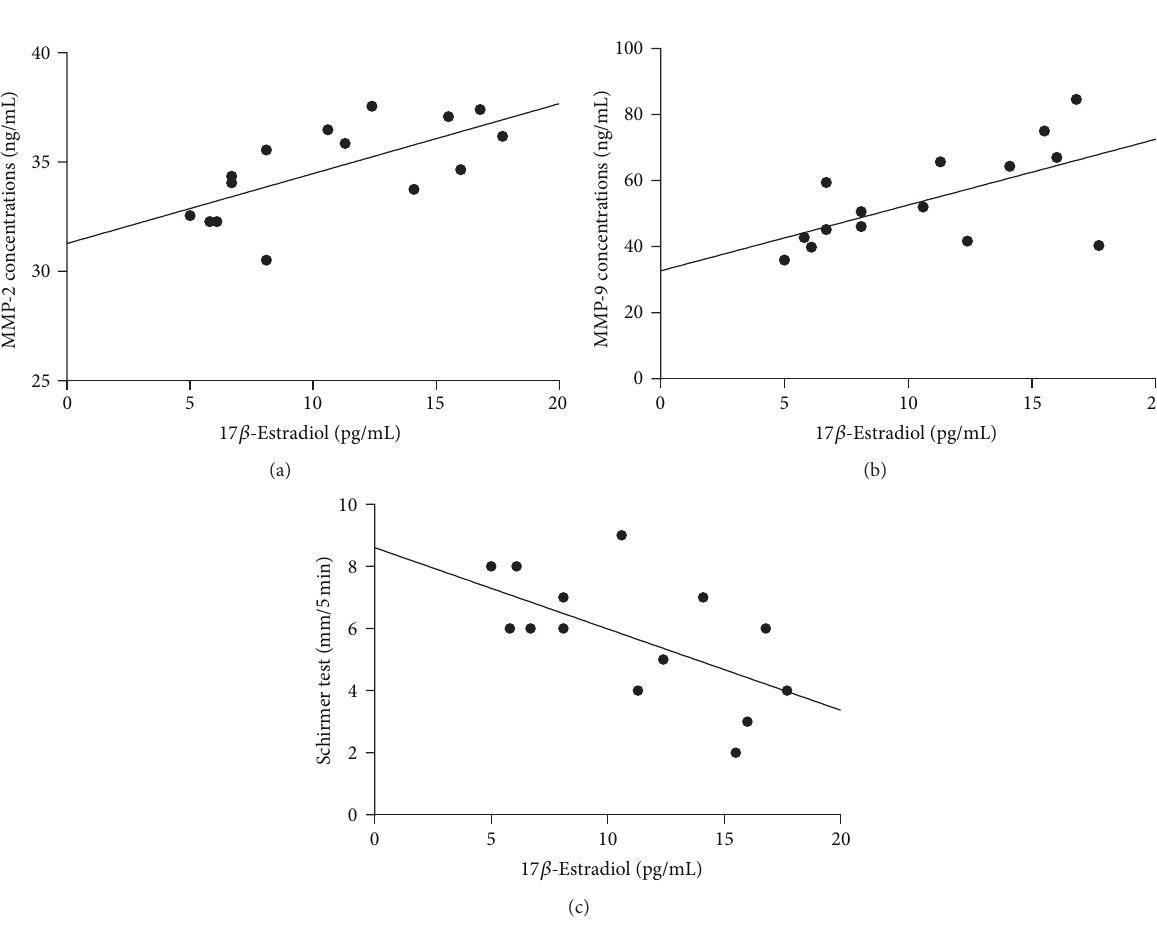
Figure 3: Correlation of 17 𝛽 -estradiol levels with (a) tear MMP-2 concentrations ( 𝜌 = 0.67, 𝑃 = 0.006 ); (b) tear MMP-9 concentrations ( 𝜌 = 0.58, 𝑃 = 0.03 ); and (c) Schirmer test results ( 𝜌 = − 0.58, 𝑃 = 0.02 ). Spearman’s rank correlation coefficients were calculated in 15 dry eye subjects who had detectable levels of 17 𝛽